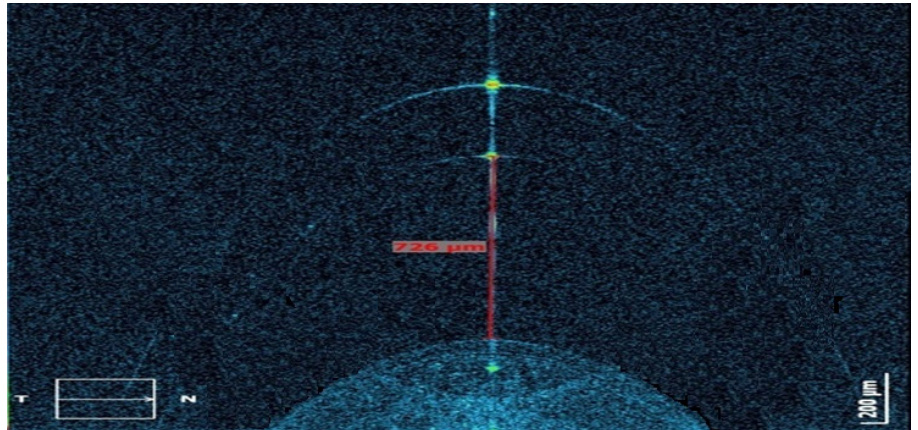
Figure 1. Measurement procedure of the central corneal clearance with the different scleral contact lenses (ScCL) fitted using the Fourier-domain optical coherence tomography (OCT) system Copernicus HR (Optopol Technology Sp. Z.o.o, Zawiercie, Poland) .